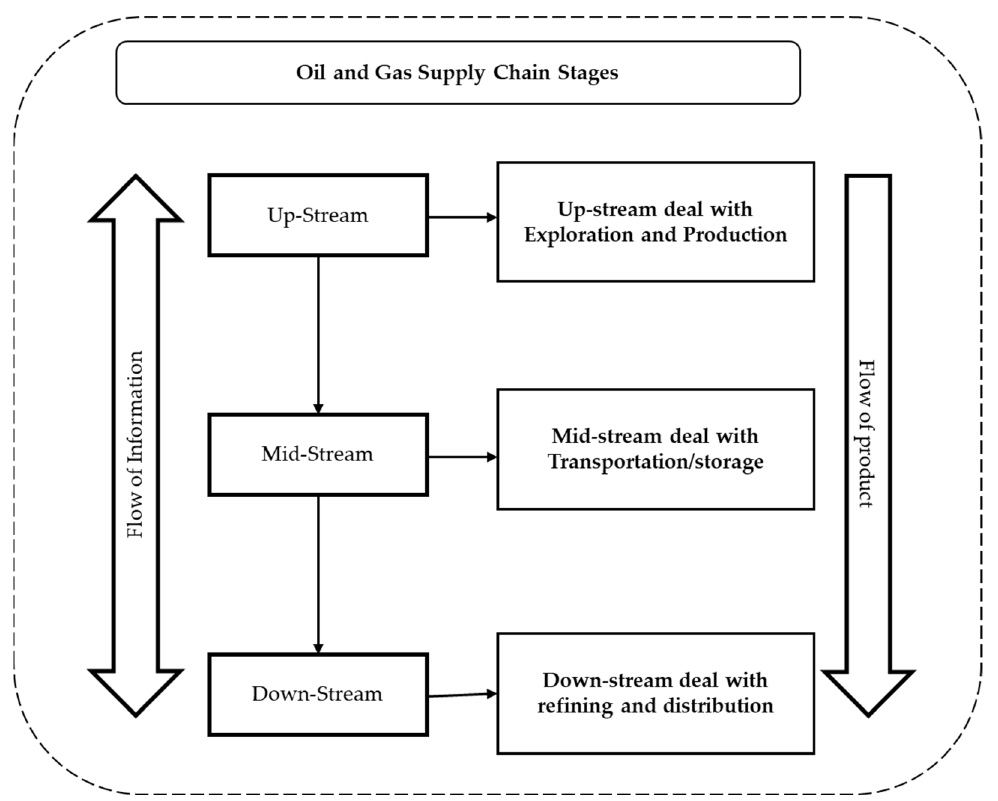
Figure 1. Oil and gas supply chain stages.